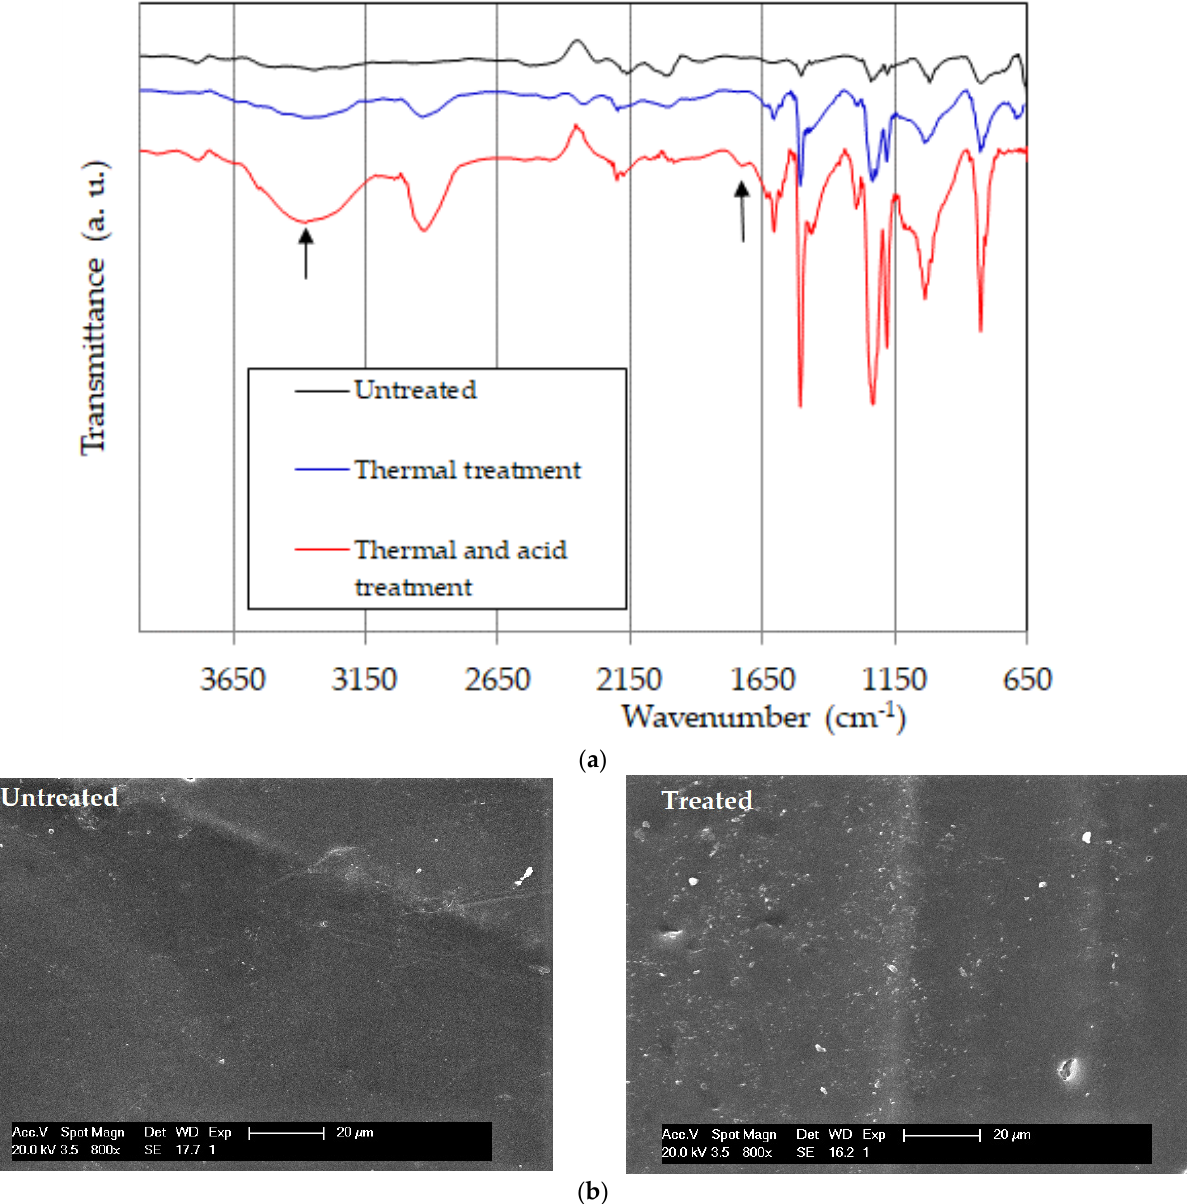
Figure 2. ( a ) FT-IR spectra of the treated and untreated fiber bundles. ( b ) SEM micrographs of the untreated and treated scraps.